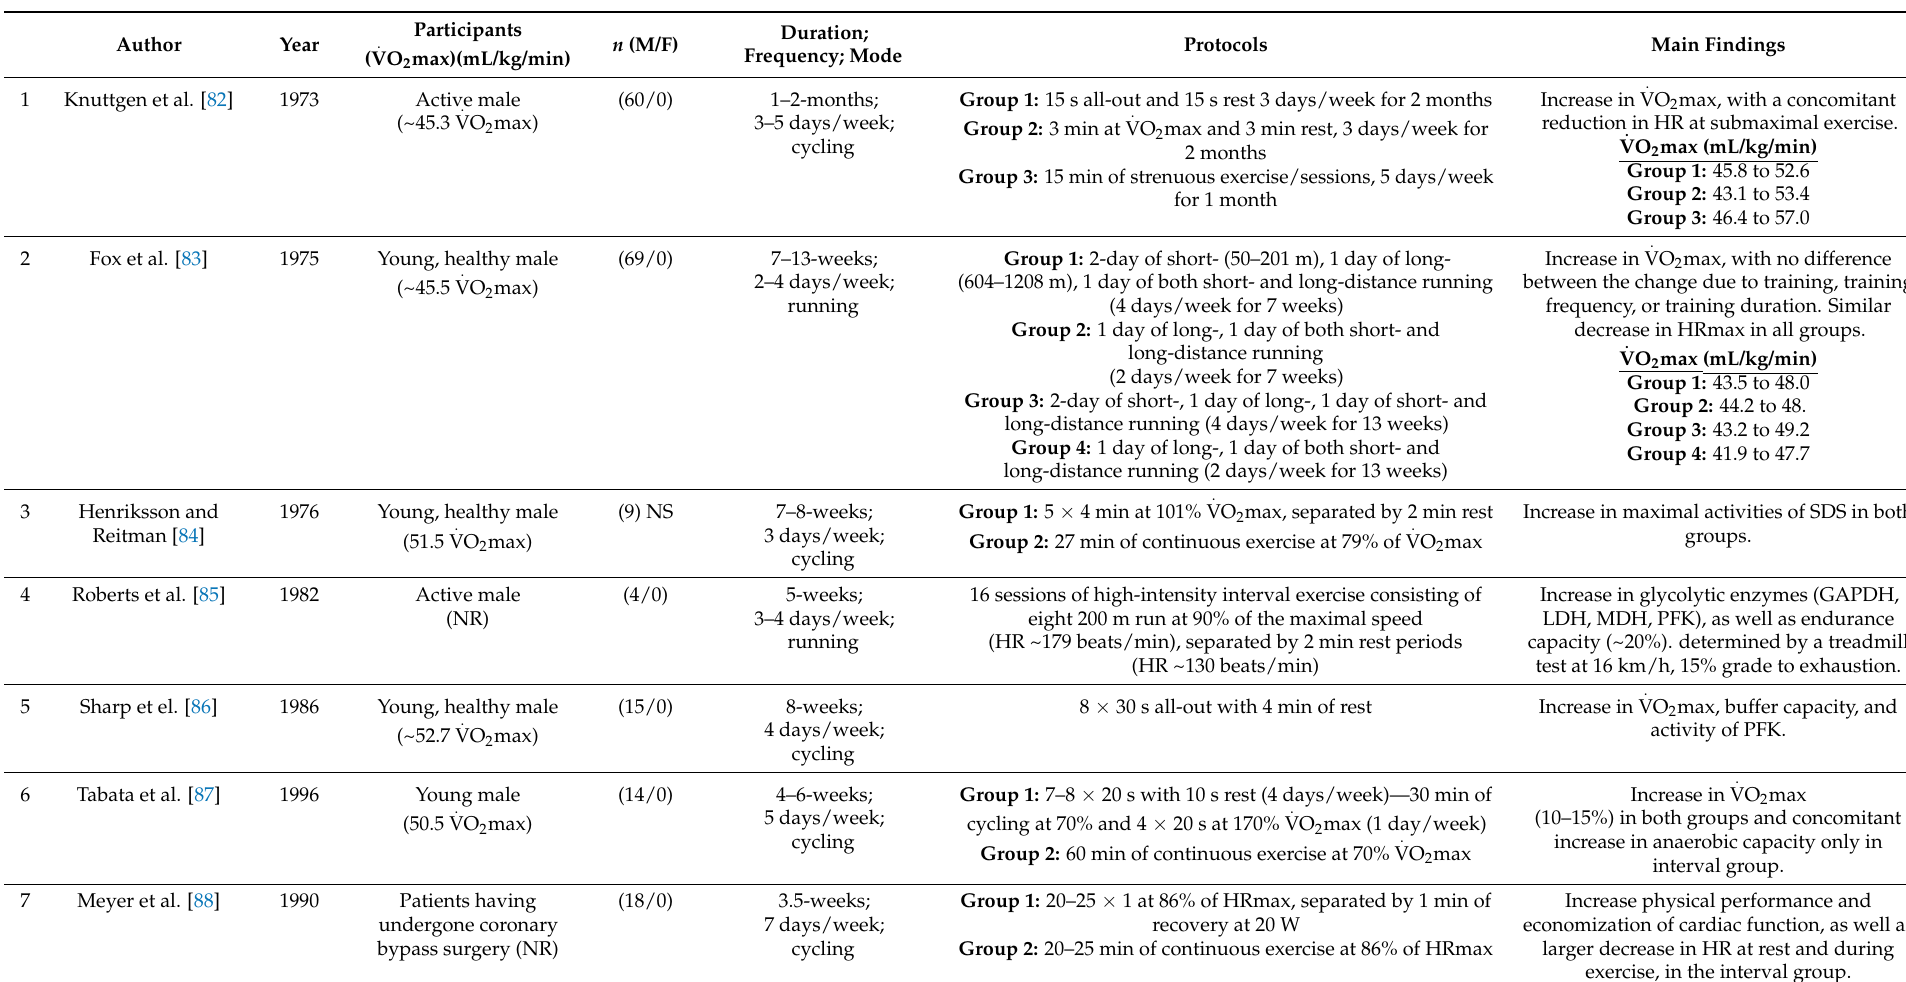
Table 1. Description of some selected HIIT